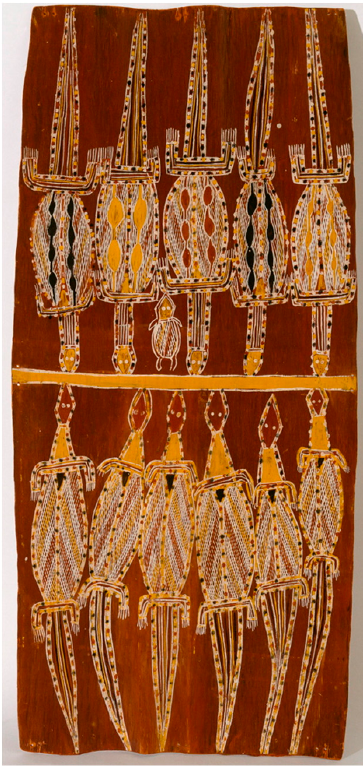
Figure 6. Djawa, Tom, Djarrka (water goanna), c1987, Natural pigments on bark, image courtesy the Art Gallery of New South Wales, Gift of Dr. Stuart Scougall. © Estate of the artist licensed by Aboriginal Artists Agency Ltd.